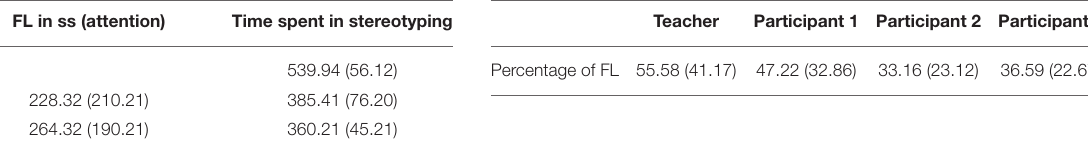
TABLE 3 | Means and (Standard deviations) of percentage of fixation length for each member of the interactive